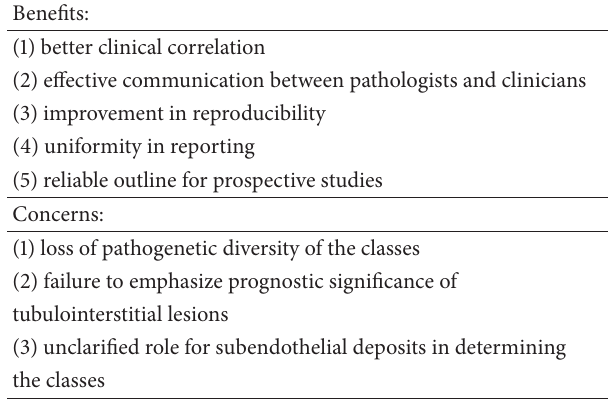
Table 4: Benefits and concerns of the ISN/RPS classification of